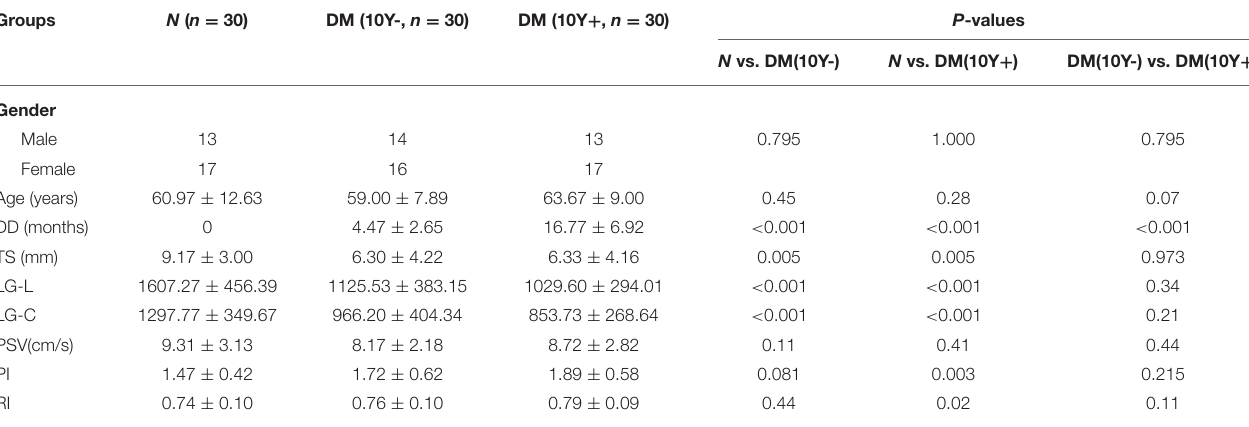
TABLE 2 | Clinical characteristics of patients with type 2 diabetes and controls by color Doppler flow imaging (CDFI).